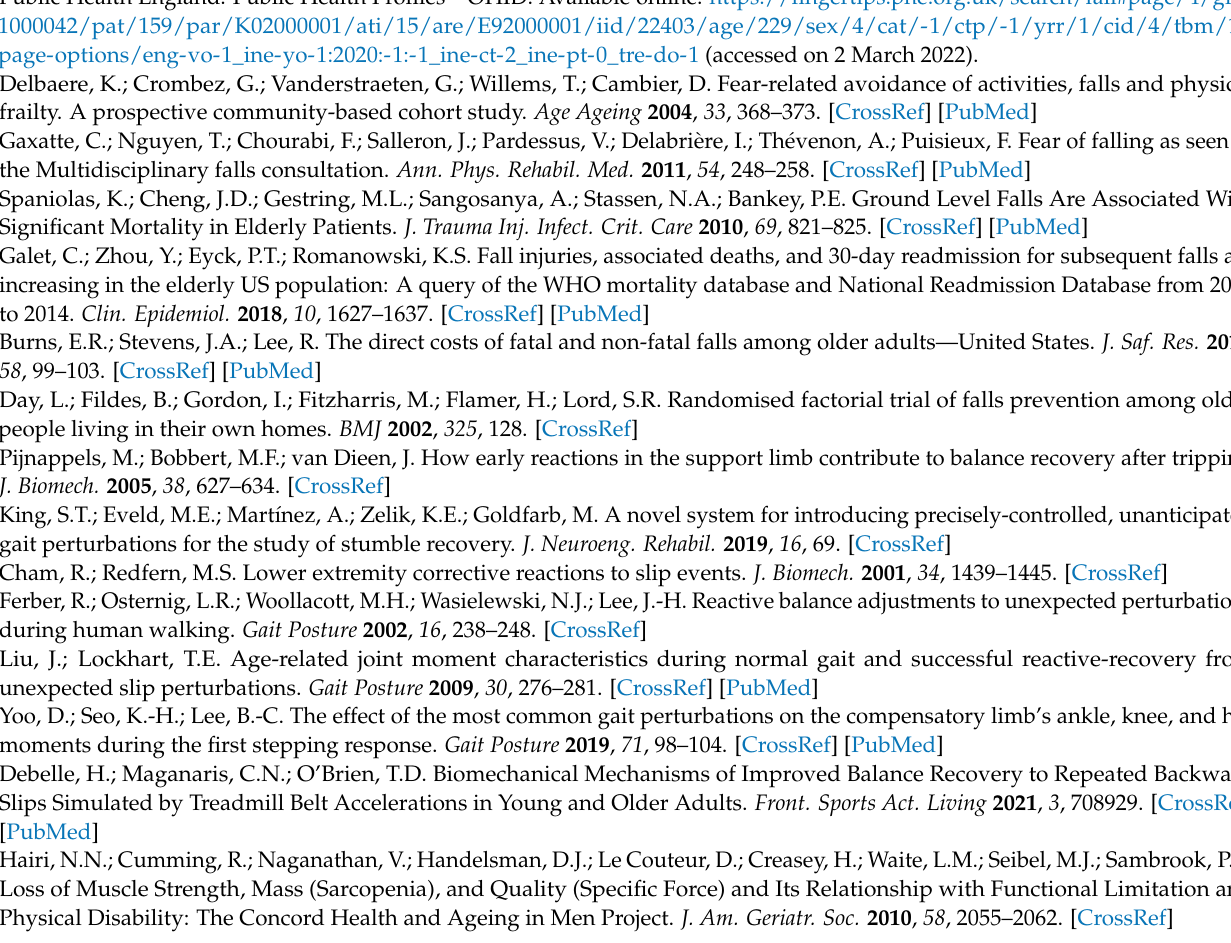
all participants thick blue line ± 1SD shaded area). The vertical black line at 25% stance represents the beginning of the belt acceleration, the dotted vertical black line at 55% stance represents the time of peak belt speed, the dashed vertical black line at 81% stance represents the time of peak ankle moment during propulsion of the perturbed